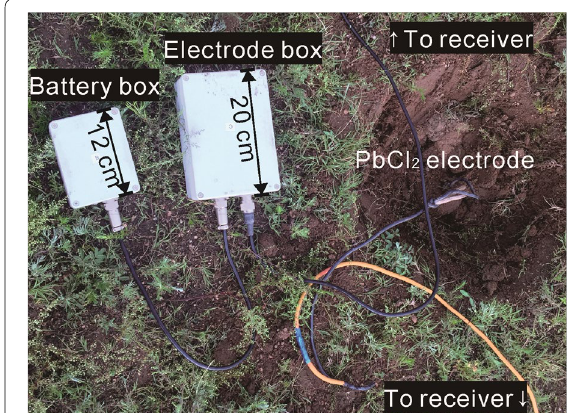
Fig. 4 Photographs of the capacitive electrode and PbCl 2 electrode